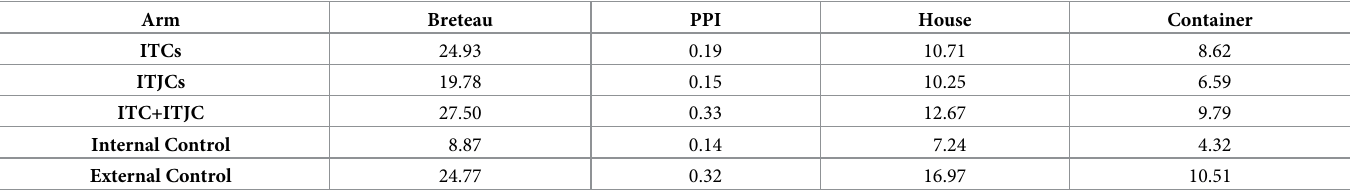
Table 1. Mean cluster-level values of the Breteau, Pupae per Person (PPI), House and Container Indices recorded at baseline in the study arms and external control arm, in Trujillo, Venezuela.